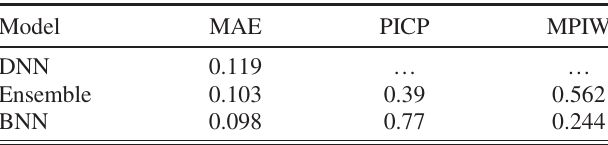
TABLE IV. Comparison of models for LCLS-II